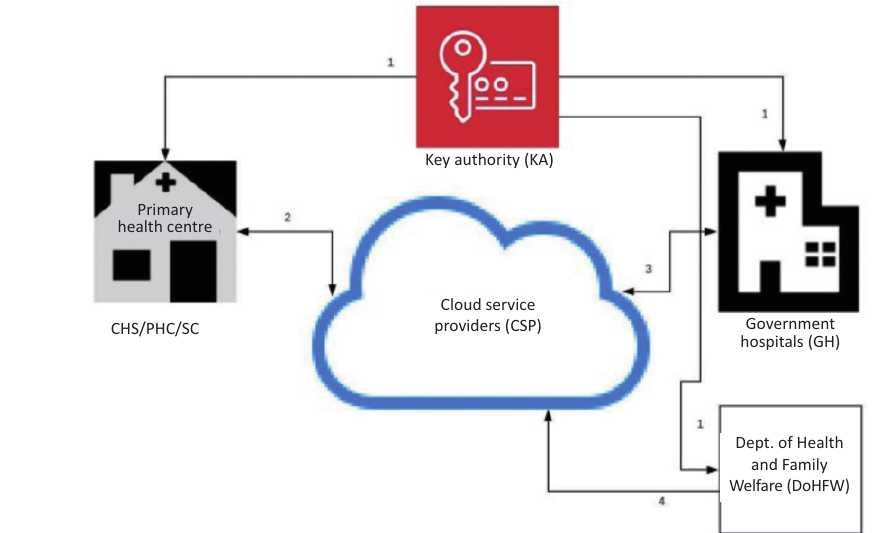
Fig. 2. General architecture of the